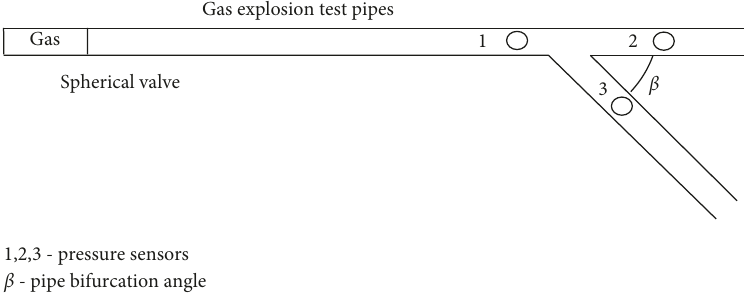
Figure 2: Experiment system of shock wave spread via the one-way bifurcation